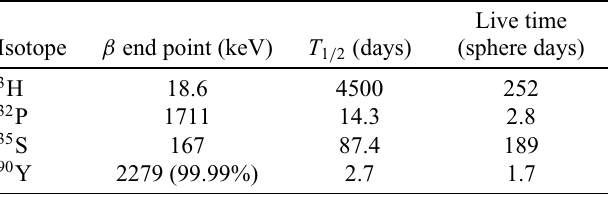
TABLE II. The selected β − -decay isotopes considered here. The energy of the end point (i.e., the maximum kinetic energy possible for the β particle) and the half-life are given for each isotope. In the case of 90 Y, the decay to the ground state is domi- nant (99.99% of decays). Rare decays to excited states of the 90 Zr daughter are also possible, coincident with either approximately 2-MeV-conversion e − or deexcitation γ . These decay branches are simulated in the MC but overlap primarily with the low T e tail of the ground-state decay and do not substantially affect the sen- sitivity at high m 4 . The live time to observe 10 4 decays is given following the assumptions in the text (i.e., 25-nm-diameter poly- mer nanospheres for 3 H, 50-nm-diameter silica nanospheres for 35 S, and 100-nm-diameter silica nanospheres for 32 P and 90 Y). FIG. 3. The calculated distribution of the reconstructed ν The isotope data are taken from Ref. momentum, | p ν | , versus the electron kinetic energy, T e , for 32 P β − decay, for various values of m 4 , assuming a 100-nm-diameter nanosphere with the detection efficiencies described in the text. The probability density for this distribution for light neutrinos (with m i ≈ 0) is shown as the black shaded histogram, sur- rounded by the 2 σ contour containing 95% of simulated events. The corresponding 2 σ contours for nonzero m 4 are indicated by the colored lines.